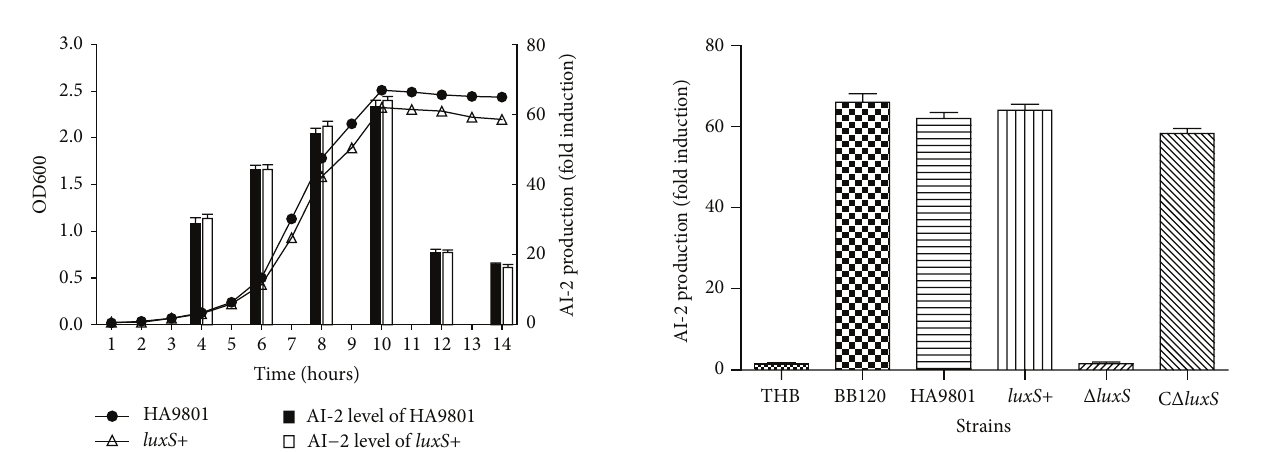
Figure 2: Growth-dependent AI-2 production by HA9801 and luxS +. The HA9801 and luxS + were inoculated to THB media and cultured at 37 ∘ C. The OD600 of the culture was determined every hour to generate the growth curve. The ∙ and Δ indicate the parental and the luxS + strains, respectively. Statistical analysis showed that 𝑃 < 0.05 at 7–14 h, indicating that the luxS + strain exhibited lagged growth relative to the WT strain. At various time points, AI-2 activity (left axis; column) is expressed as the fold induction of relative light units by comparing the level of luminescence to that induced by sterile medium. Values are means from three independent experiments.